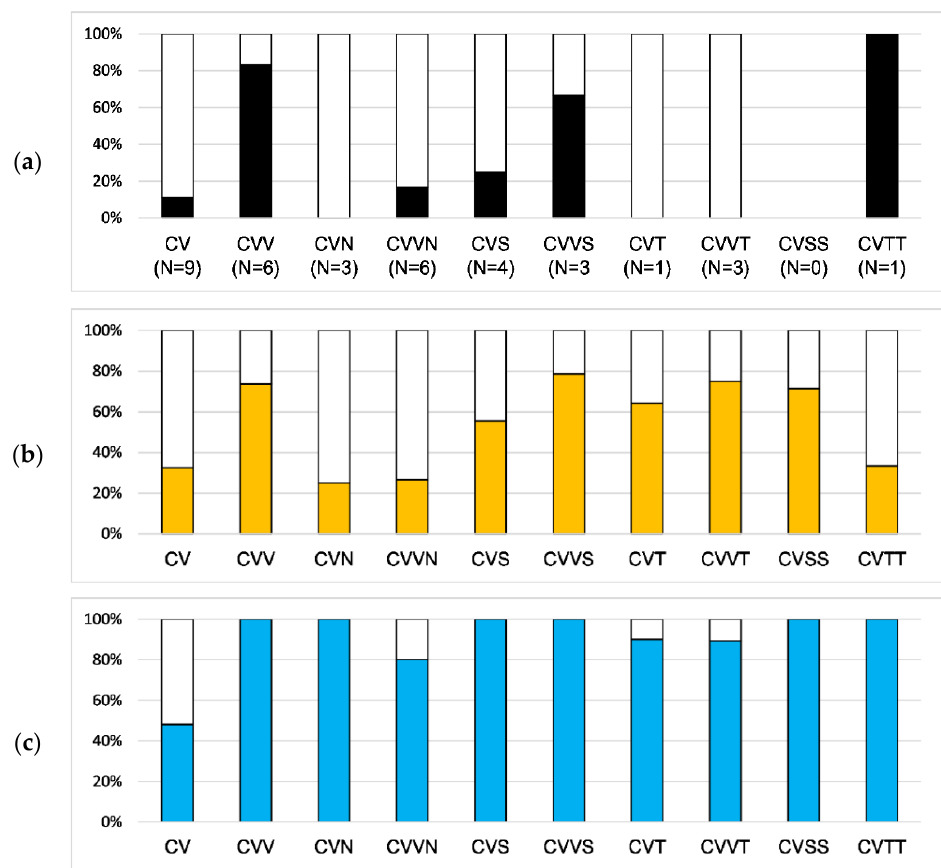
Figure 9. Proportion of turns displaying laryngealization by syllable type/shape and by register for ( a ): fusħa ‘formal’ (F); ( b ): wus ṭ a ː ‘careful’ (W); and ( c ): ʕ a ː mijja ‘casual’ (A) . Key to syllable codes: C: